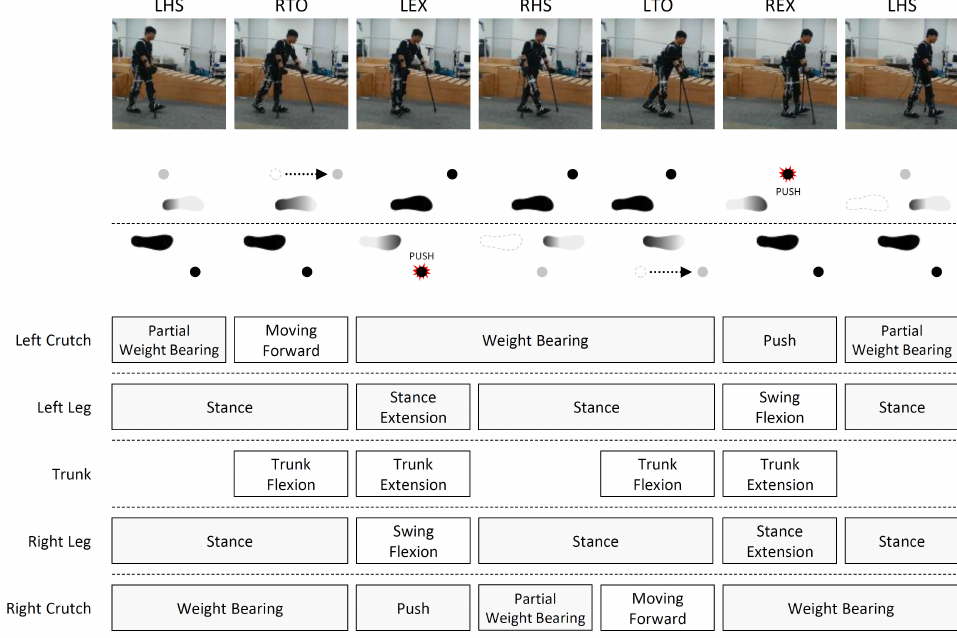
Figure 6. Sequence pattern of 4-point gait